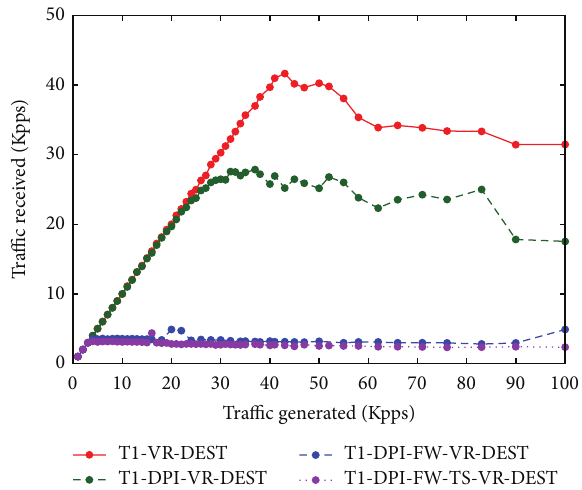
Figure 17: Received versus generated packet rate for one tenant (T1) when four tenants are active, with 64 -byte IP packet size and different levels of VNF chaining as per Figure 7. DPI: deep packet inspection; FW: firewall/NAT; TS: traffic shaper; VR: virtual router; DEST: destination.